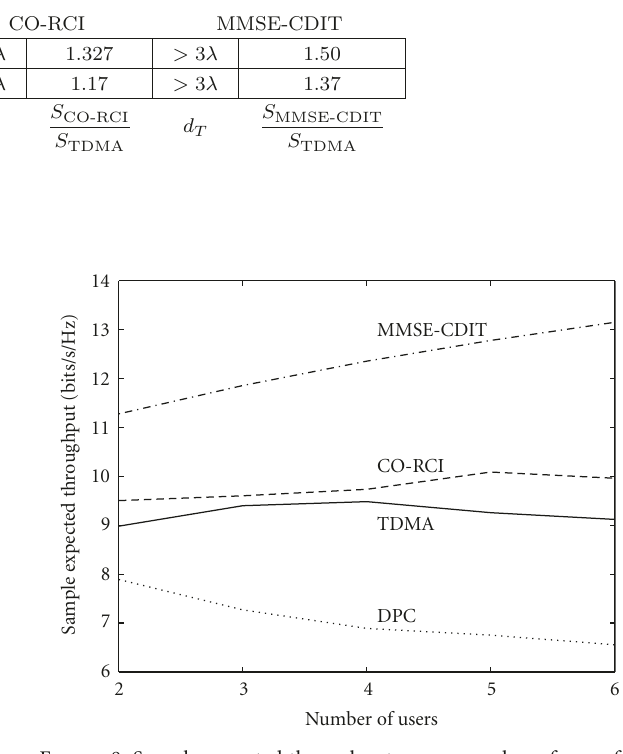
Figure 7: Sample expected throughput versus the number of users for N t = N r = 4 and P = 10 in the measured channel. There is no lag between channel acquisition and use.